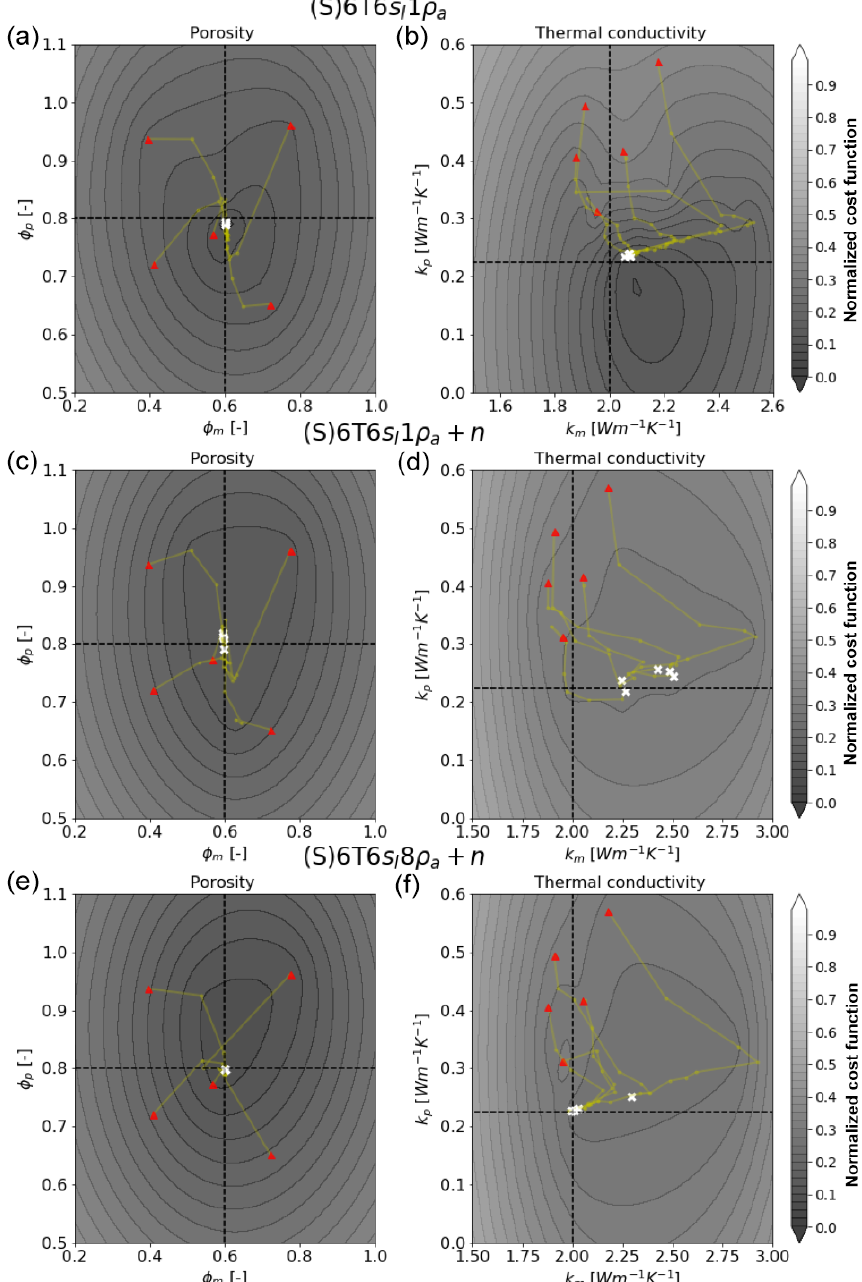
Figure 5. Estimated properties from five inversions of the three different cases, where the true values are shown as a cross section of the two dashed lines for the bulk porosities and effective thermal conductivities for peat and mineral soil layers. Yellow lines correspond to the paths taken by the LM algorithm. The white dots correspond to the estimated values. The rows from top to bottom correspond to cases (S)6T6s l 1 ρ a (a, b) , (S)6T6s l 1 ρ a + n (c, d) , and (S)6T6s l 8 ρ a + n (e, f) respectively. The columns from left to right correspond to the projection of the cost function with respect to porosities and thermal conductivities. The color bar represents the cost function normalized by its maximum logarithmic